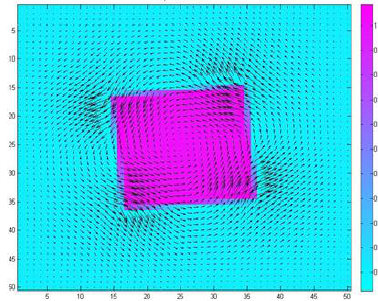
Figure 4. Results of Horn/Schumck